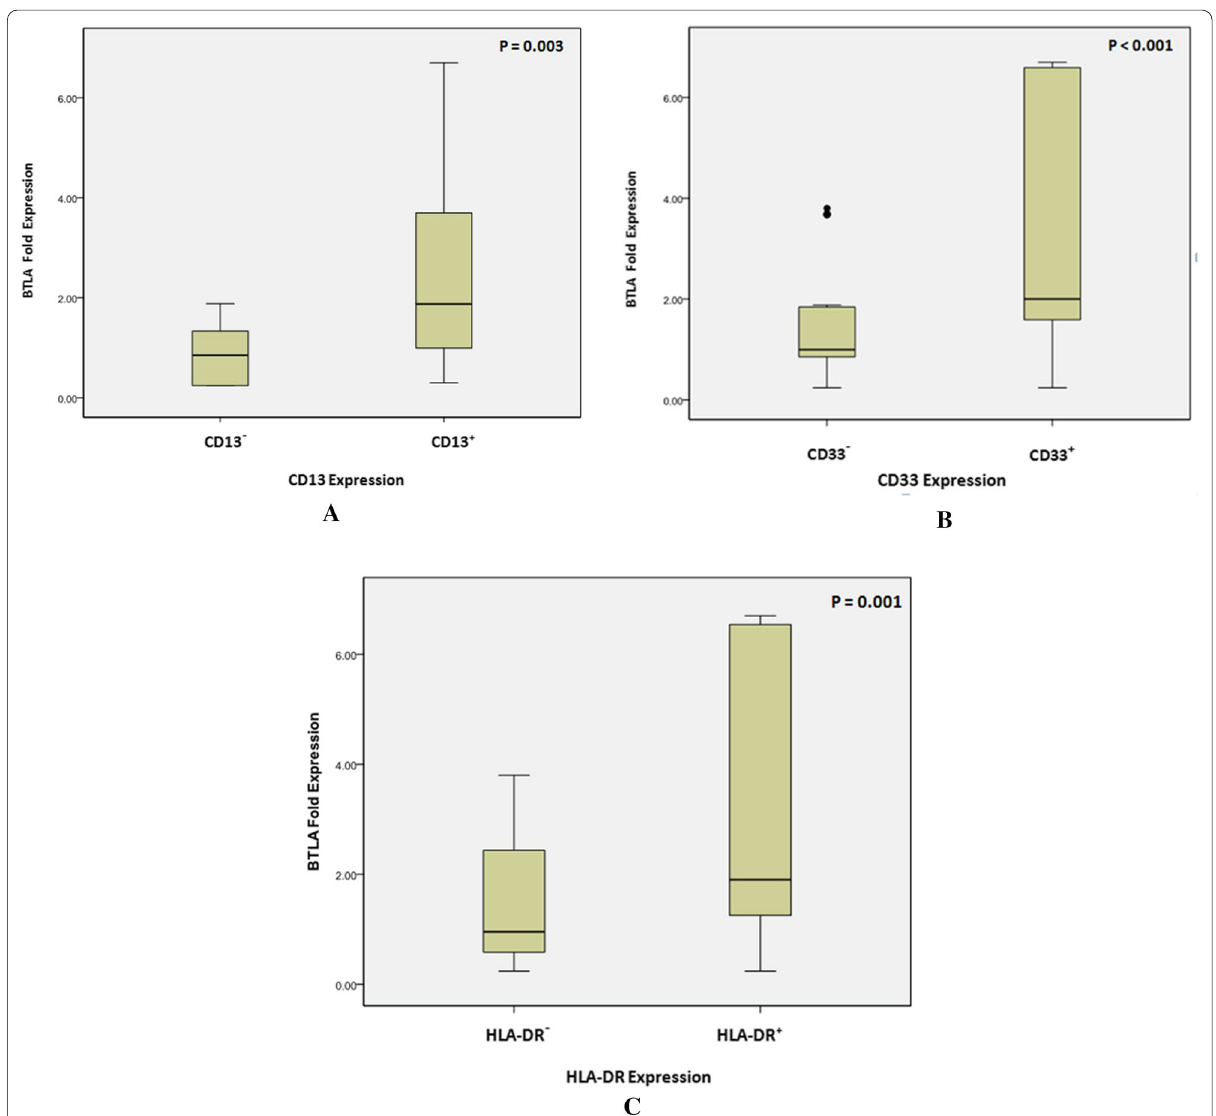
Fig. 2 BTLA fold expression with respect to A CD13 expression, B CD33 expression, C HLA‑DR expression. Box represents the interquartile range. Line inside the box represents the median. Whiskers represent minimum and maximum